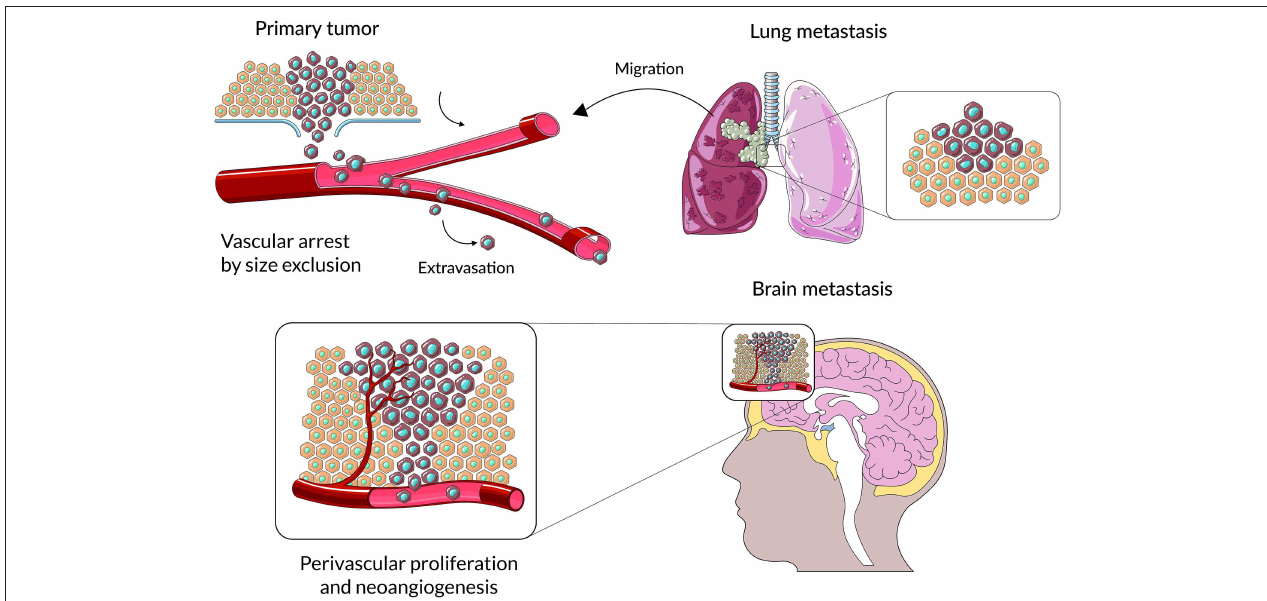
FIGURE 1 | A schematic representation of main stages cancer cell colonization of brain parenchyma. Cancer cells from primary lesions invade into surrounding tissues, intravasate into the circulatory system and survive during hematogenous transit. Metastatic cells arrest at distinct sites and extravasate through vascular walls into the brain parenchyma. At the metastatic niche cancer cells proliferate, form colonies in this parenchyma; and the subsequent proliferation of cells leads to clinically detectable metastatic lesions.